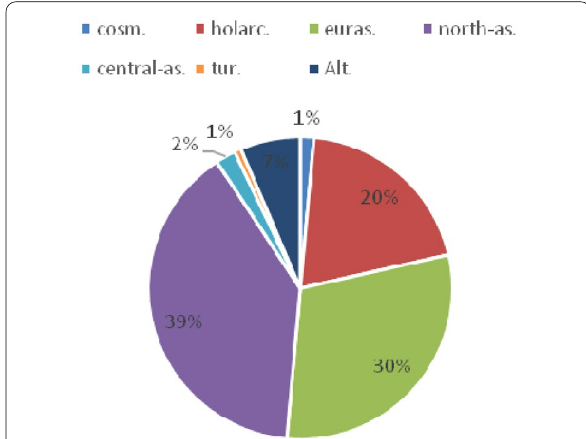
Fig. 10 Chorological analysis of R. rosea habitats: cosm., cosmopolitan; holarc., Holarctic; euras., Eurasian; north-as., north Asian; tur., Turanian; Alt, Altai (endemics of the Altai-Sayan botanical-geographical province)